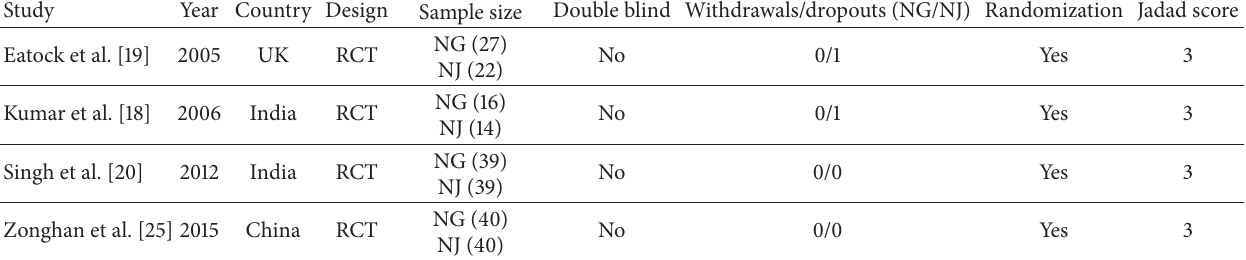
Table 1: Characteristics and quality of the included RCTs.